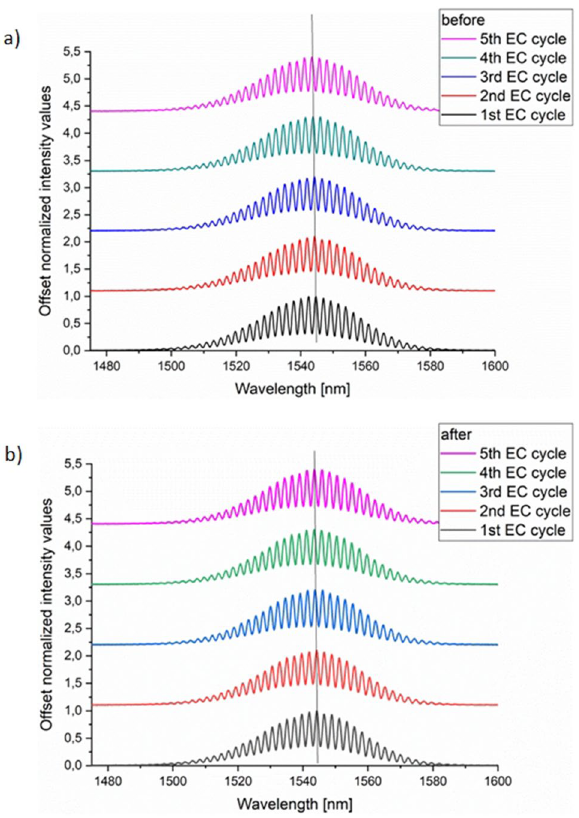
Figure 4. Stacked spectra split into before and after according EC cycles groups. The results allow for comparison of signals obtained in the time series of repeated measurements. As seen, the signals’ envelopes remain approximately the same, suggesting no measurement-induced alterations were introduced to the electrochemical reactions. Vertical lines are to guide an eye to spot slight spectral shifts, if any (likely due to the light source